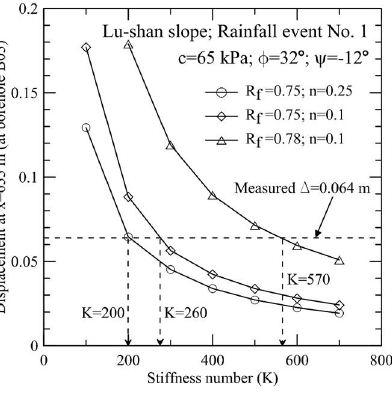
Figure 19. Results of back-analyses for displacement-related parameter K various values of c and Δ φ .